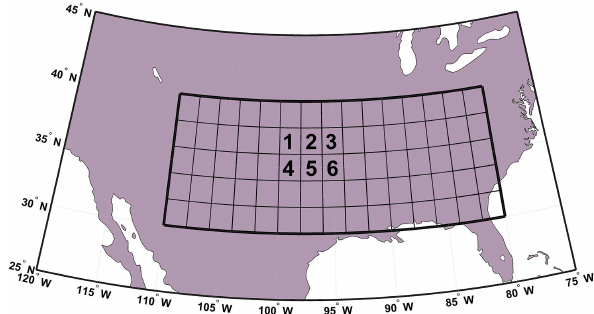
Figure 1. Study domain. The six numbered pixels are used in Sect. 5 for evaluation of TC assumptions in estimating